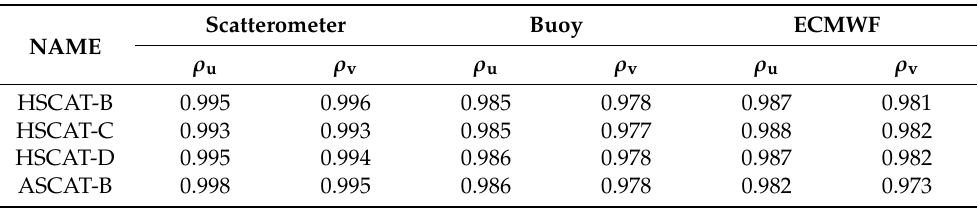
Table 5. The correlation coefficient in u and v wind components from the ETC of the scatterometer with buoy and ECMWF Table 4. Standard deviations of errors in the u and v wind components obtained from the ETC of the scatterometer with buoy and ECMWF winds.